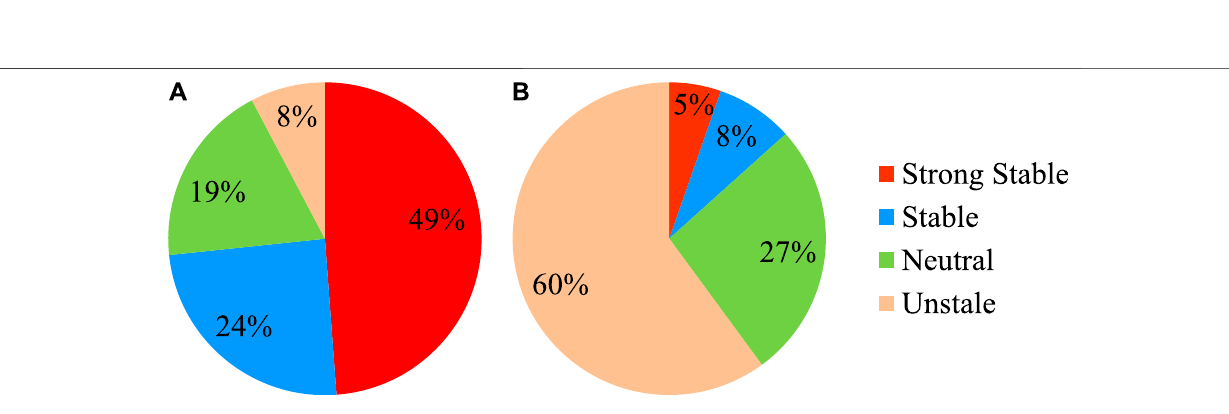
Frontiers in Energy Research |